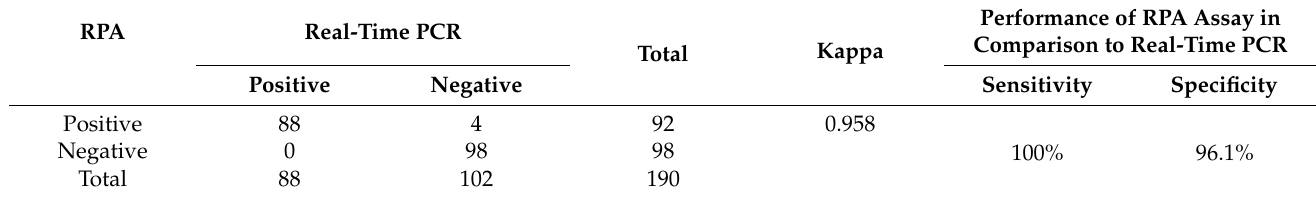
Table 3. Comparison of RPA assay and real-time PCR for M. pneumoniae